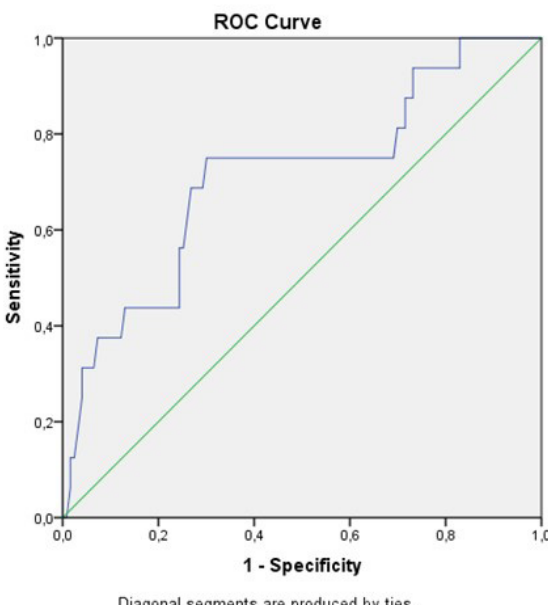
Fig. 2 - Receiver operating characteristic (ROC) analysis of optimal albumin-bilirubin